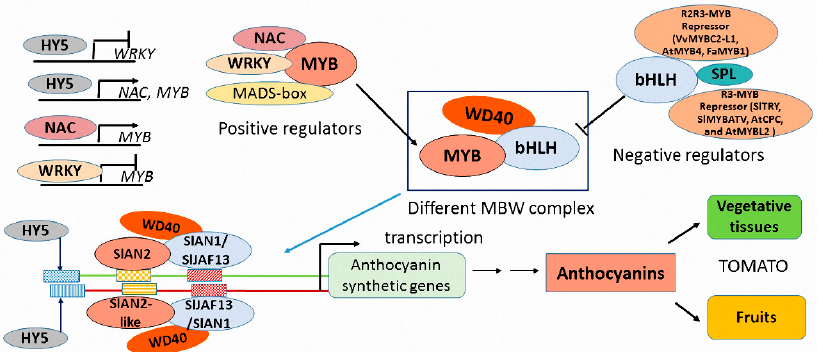
Figure 2. The regulatory pathway of anthocyanin biosynthesis in plants. NAC, WRKY, MADS-box can interact with MYB to form BMW complex and positively regulate the expression of anthocyanin synthetic genes. In the regulatory pathway, the expression of NAC , MYB is regulated by HY5, NAC, and WRKY, and the expression of WRKY is also regulated by HY5. However, some negative regulators such as VvMYBC2-L1, AtMYB4, FaMYB1 belonging to R2R3-MYBs, SlTRY, SlMYBATV, AtCPC, and AtMYBL2 belonging to R3-MYBs interact with bHLH to compete with MYB and disturb the MBW complex. Another negative regulator SPL can also interact with bHLH to affect MYB- bHLH-WD40 complex. The transcription factor HY5 and MBW complex which consists of different MYB proteins such as SlAN2 and SlAN2-like and bHLH proteins such as SlAN1 and SlJAF13 in tomato can bind to the promoters of different anthocyanin synthetic genes to activate their transcription and accumulate anthocyanin in specific vegetative tissue or